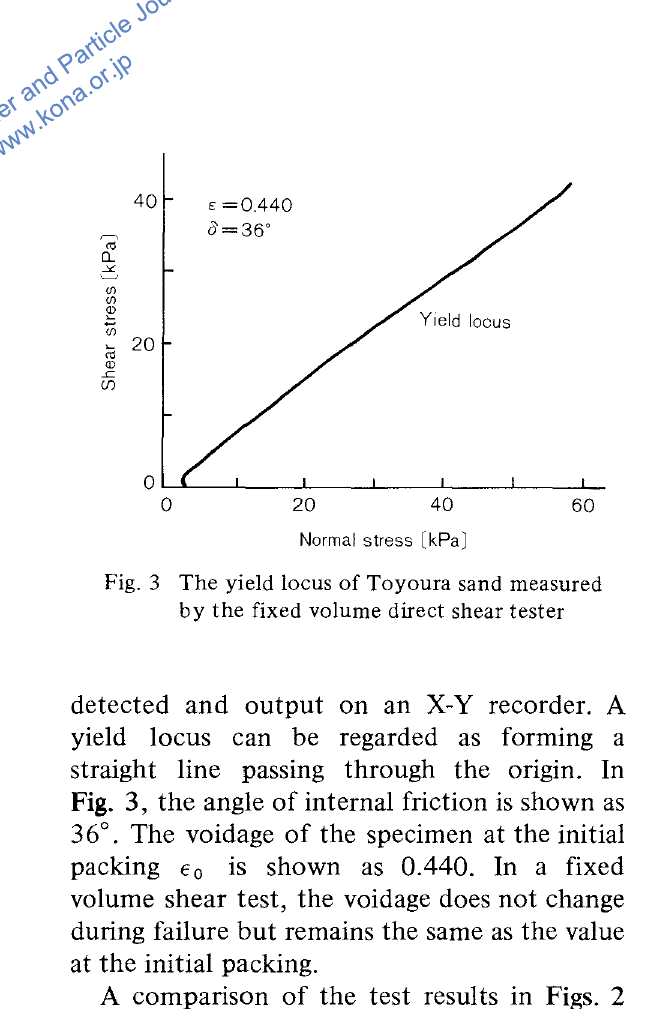
Fig. 3 The yield locus of Toyoura sand measured by the fixed volume direct shear tester